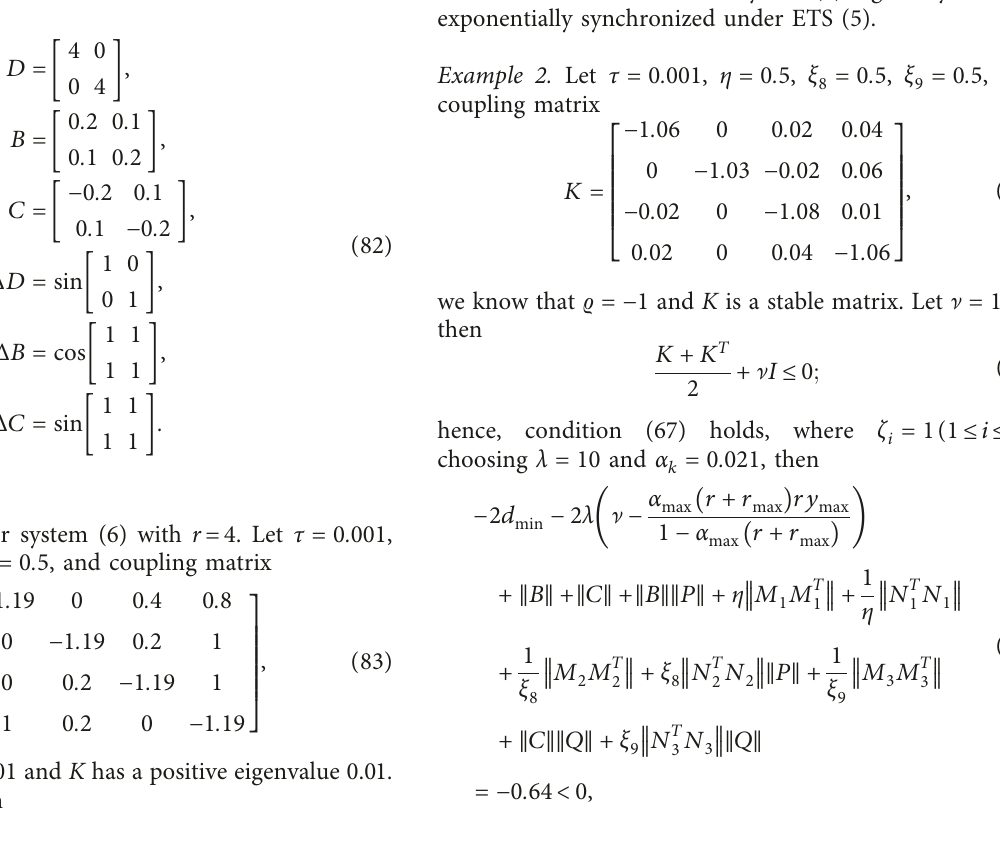
Figure 1 describes the evolutions of the event-triggered controller and synchronization errors. Figure 2 depicts the threshold and the evolutions of measurement errors. By Theorem 2, we can know that system (6) is globally robustly exponentially synchronized under ETS